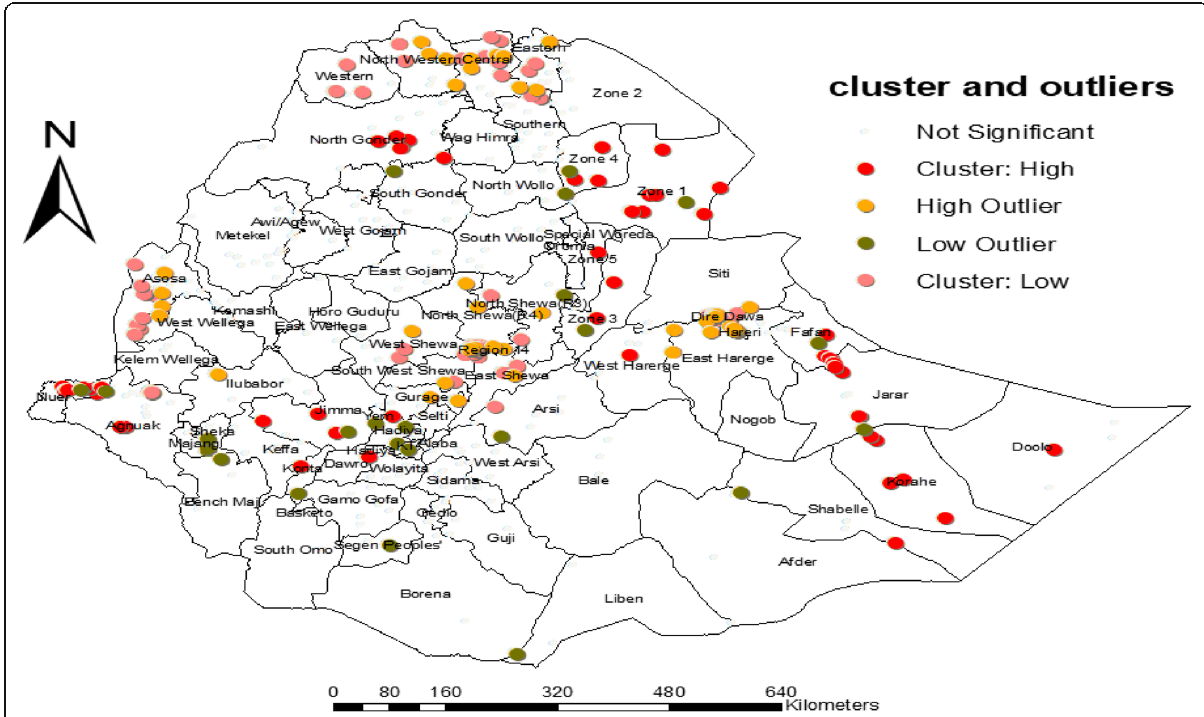
Fig. 4 Clusters of defaulting immunization among children aged from 12 to 23 months in EDHS